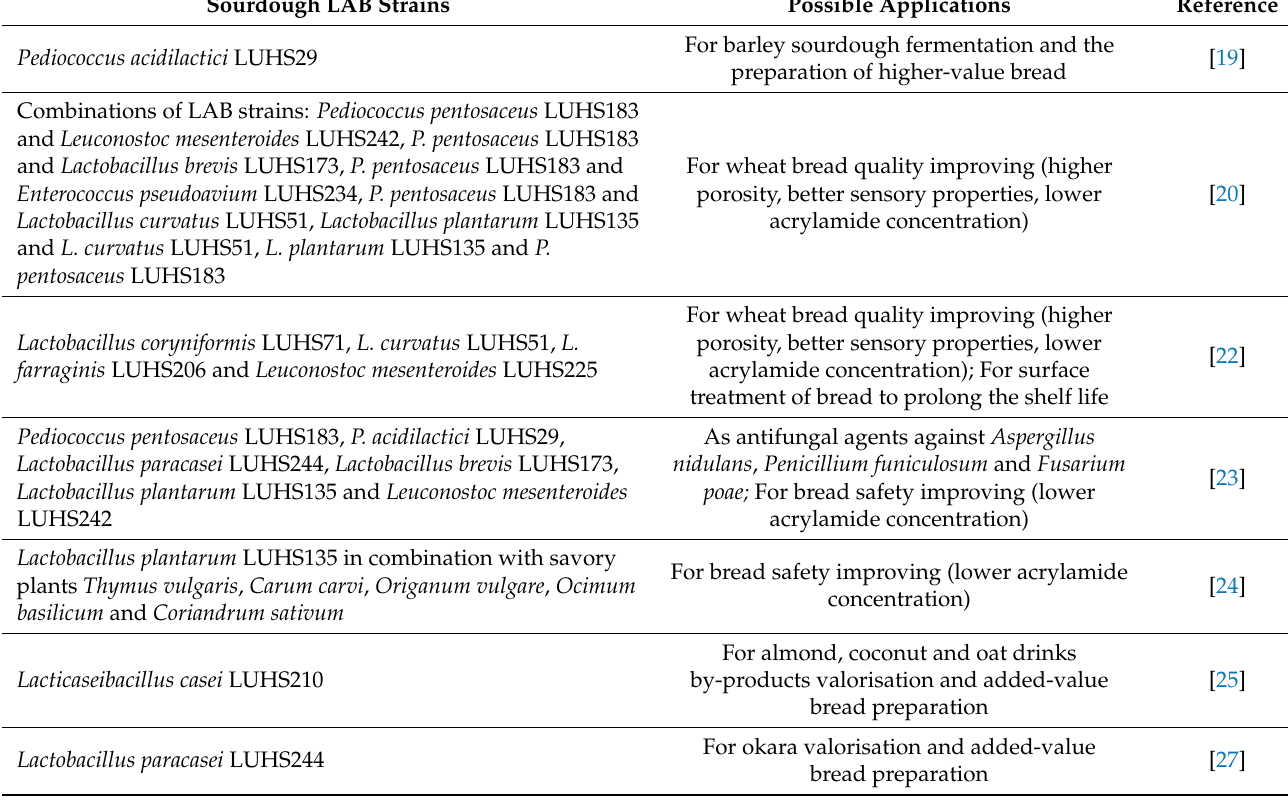
Table 1. Possible applications of sourdough lactic acid bacteria (LAB) in bread preparation. Sourdough LAB Strains Possible